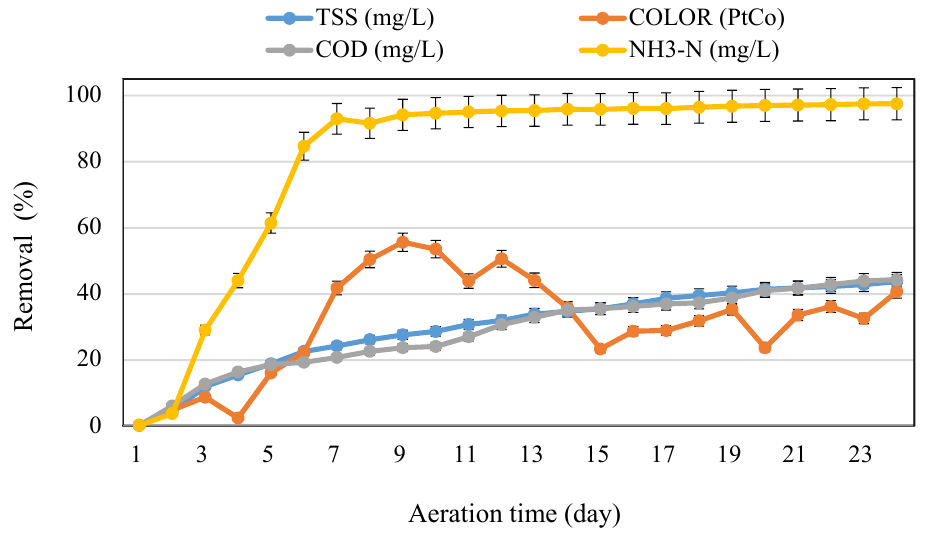
Figure 1. Effects of reaction time variation on COD, TSS, color, and NH 3 -N removal efficiency (with natural pH, leachate only, aeration 20 L/min).